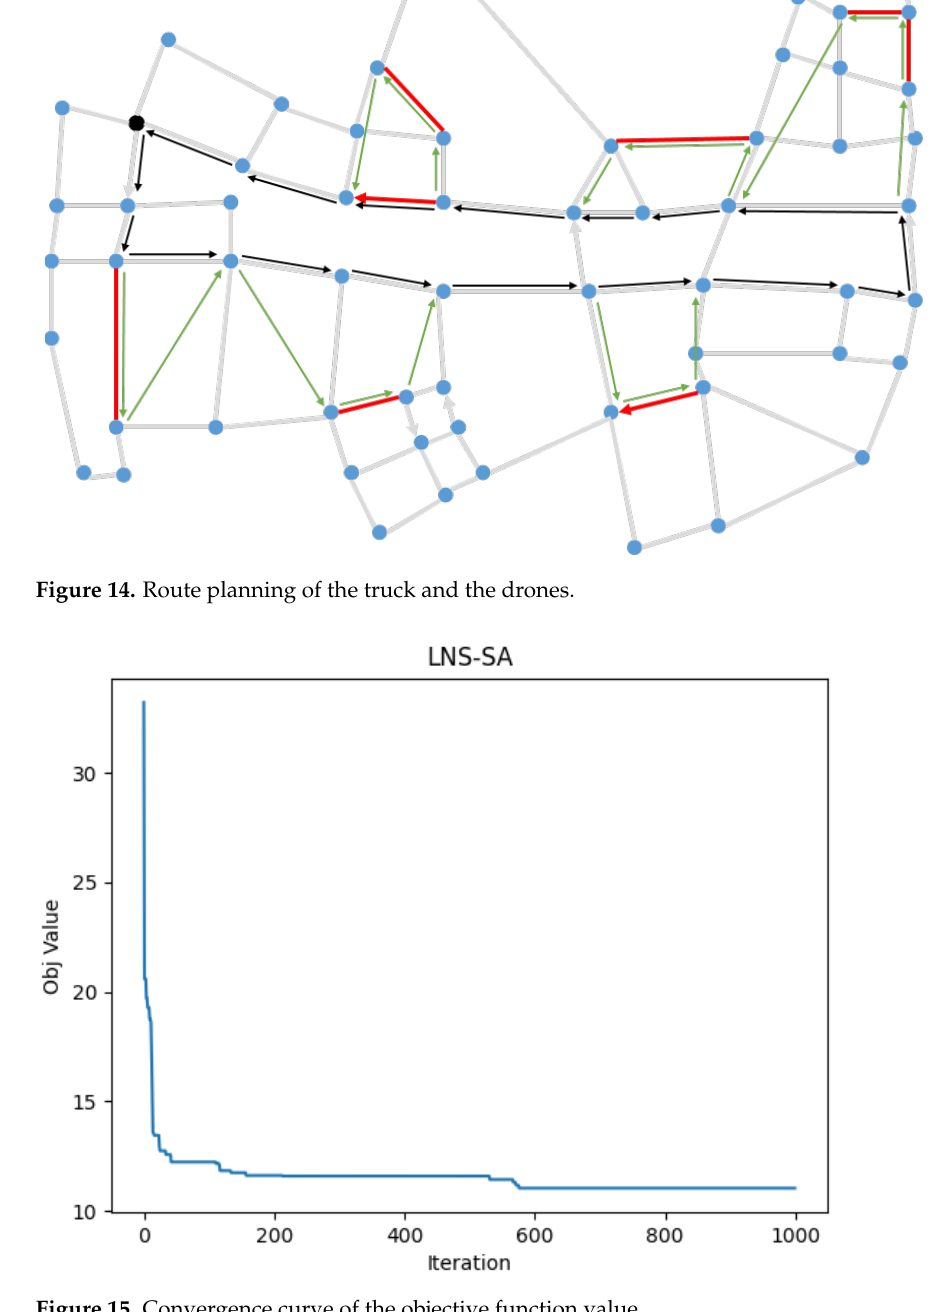
Figure 15. Convergence curve of the objective function value.